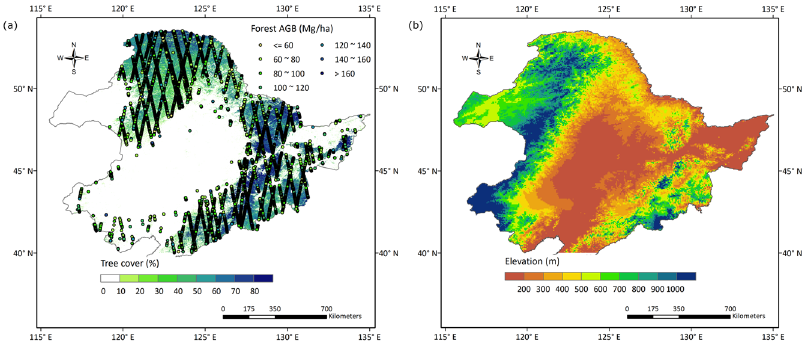
Figure 1. The study area: ( a ) the red triangles showed the field measurements in the Tahe county and Changbai Mountain region, and the points showed the GLAS footprints located in the forest region of the study area as well as their AGB values. The background map shows the spatial distribution of tree cover; and ( b ) shows the elevation map of the study area.